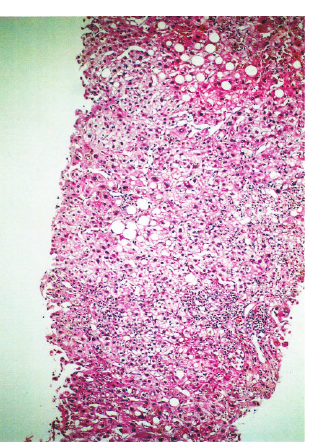
Figure 1: A portal tract showing prominent infiltration of mononu- clear cells with sparse polymorphic leucocytes. Existence of exten- sive bile pigments in parenchyma and mild steatosis in portal tracts is striking (hematoxylin-eosin stain; original magnification × 10).